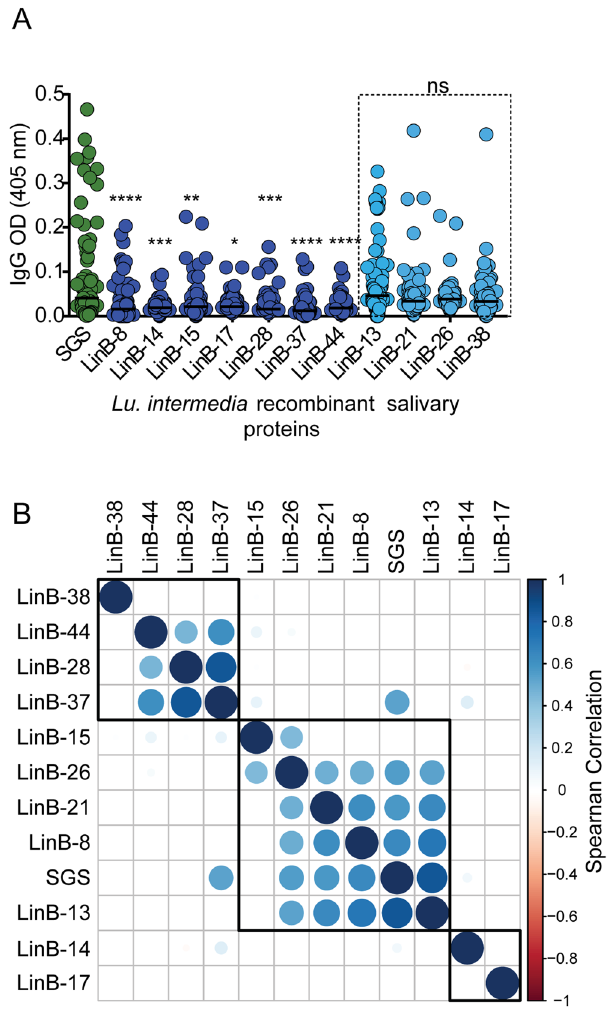
Figure 1. Screening Lu. intermedia salivary proteins for markers of vector exposure. ( A ) Total IgG response against Lu. intermedia SGS and recombinant salivary proteins was measured by ELISA in residents of a CL- endemic area (n = 89). Data are shown individually and black lines represent the median OD value for each antigen. All statistical analysis were performed in comparison to Lu. intermedia SGS. ( B ) Correlation matrix of IgG antibodies against Lu. intermedia SGS and recombinant salivary proteins in the same individuals represented in ( A ). Circles represent individual OD values, as shown in ( A ) Blue circles depict a positive Spearman correlation. Circle diameter and intensity of blue color depict higher Spearman r values. * P < 0.05; ** P < 0.01; *** P < 0.001; **** P <